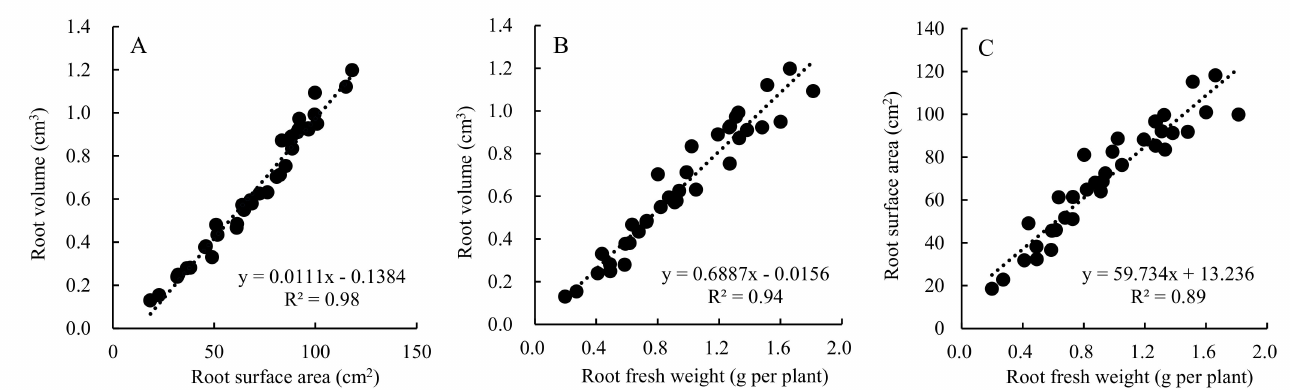
Figure 7. Relationships between ( A ) root surface area and root volume, ( B ) root fresh weight and root volume, and ( C ) root fresh weight and root surface area of cucumber seedlings at 21 days after sowing in a closed transplant system. R 2 represented correlation coefficient; x and y represented the abscissa and ordinate values, respectively.